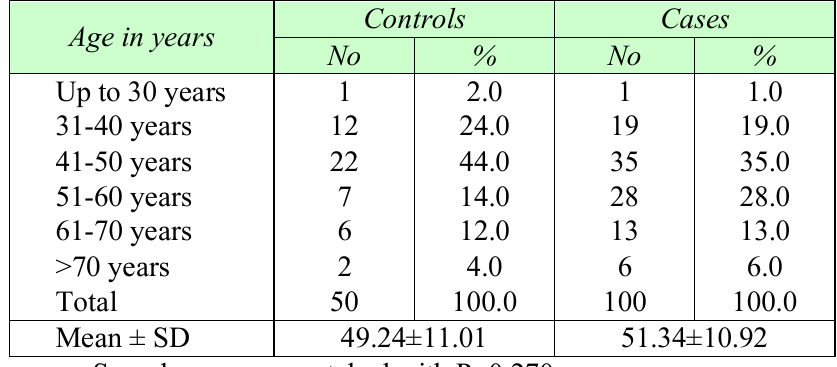
Table 1: Age distribution of subjects studied